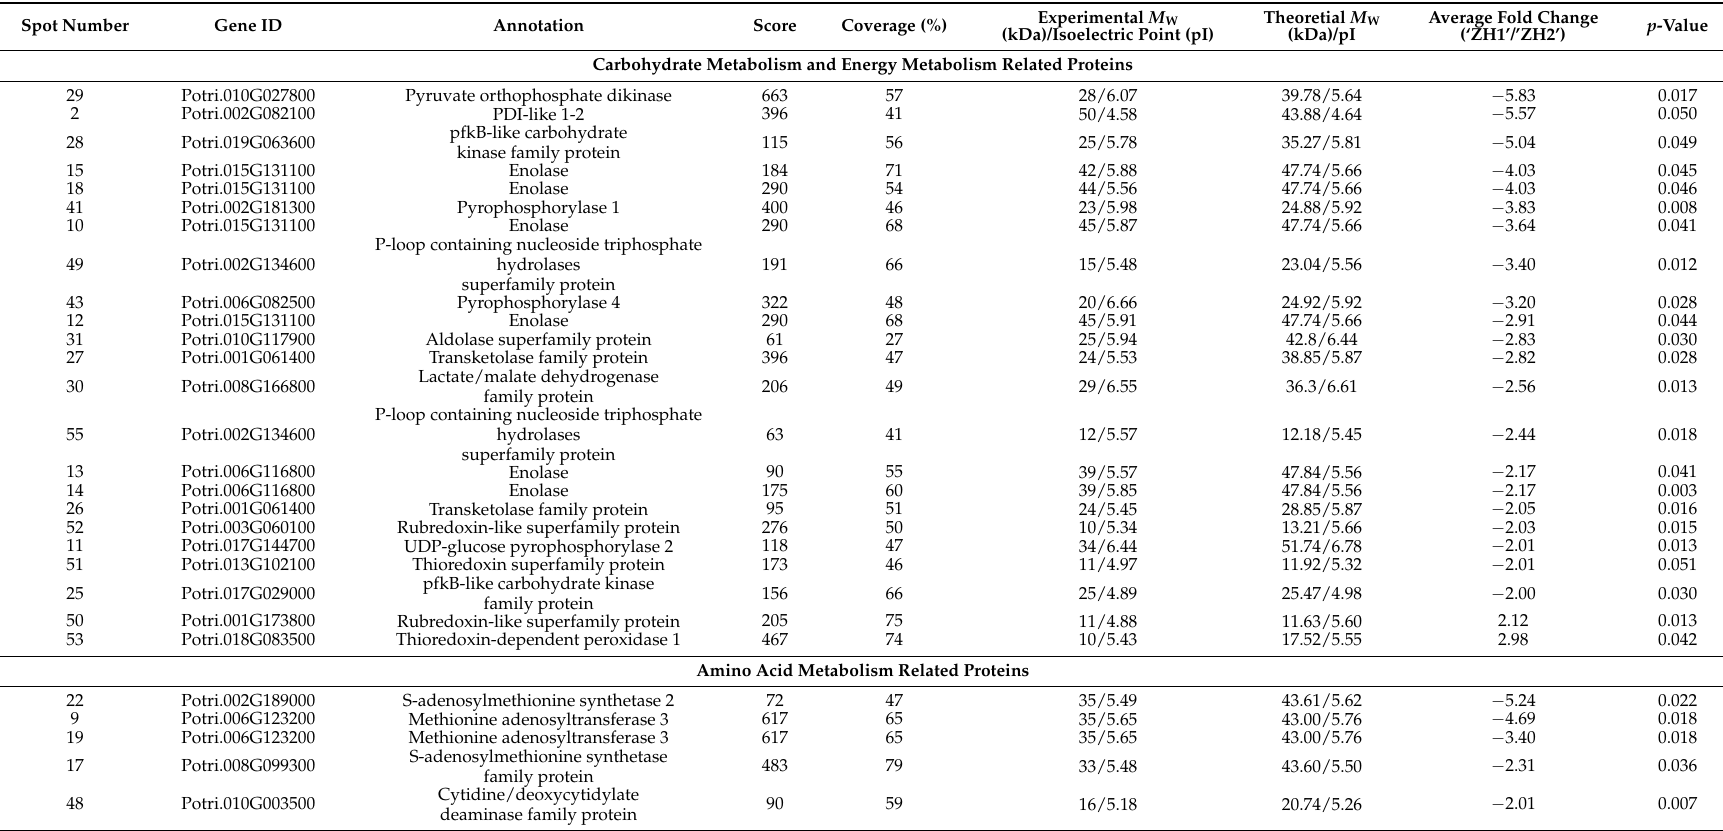
Table 1. Differentially expressed protein spots (DEPs) identified in the pollen of triploid ‘ZH1’ and diploid ‘ZH2’ P. deltoides